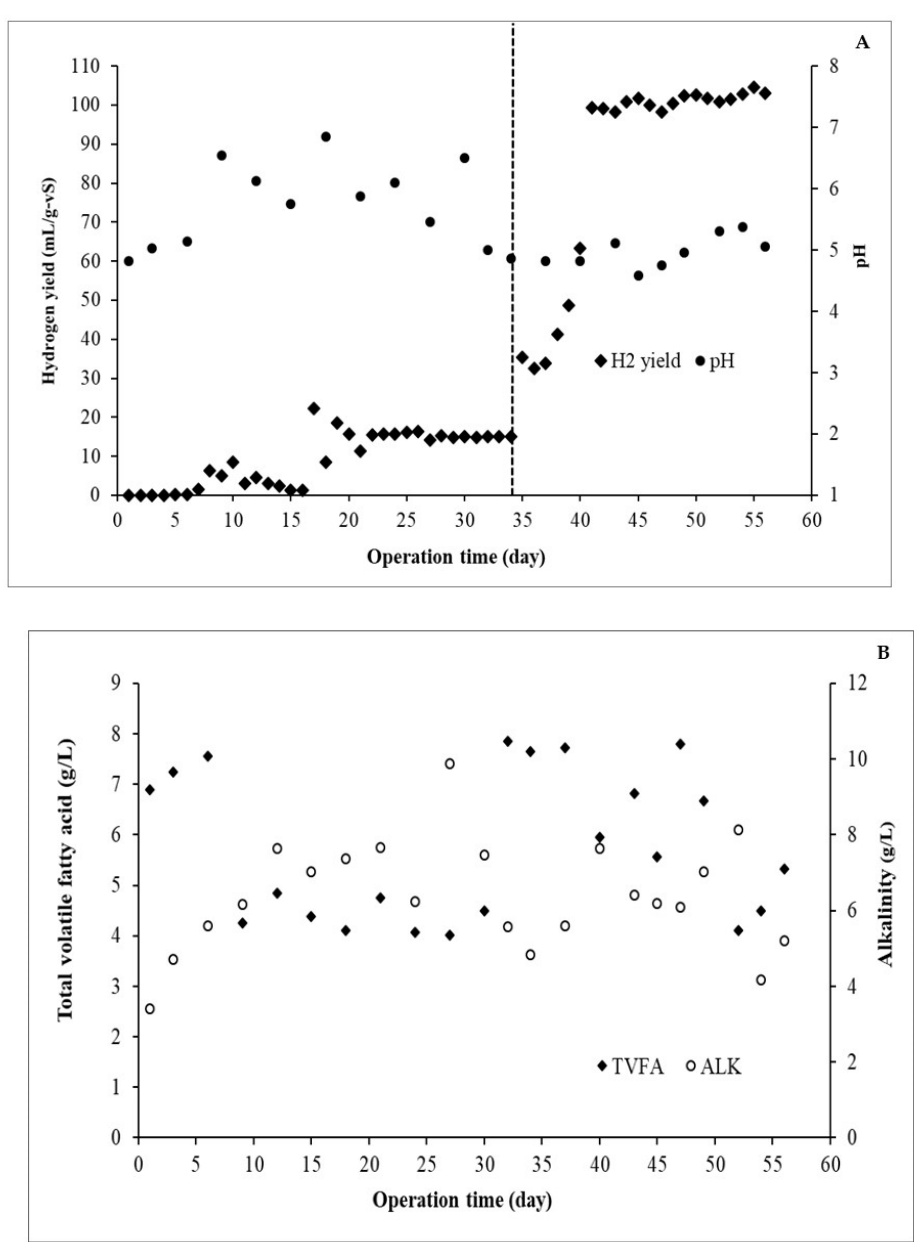
Figure 3. Hydrogen yield and pH ( A ) and total volatile fatty acid and alkalinity concentrations ( B ) during the continuous hydrogen production from DW and GW co-digestion at 99:1 (% v / v ). The solid triangle and transparent circle symbols are total volatile fatty acid (TVFA) and alkalinity (ALK),